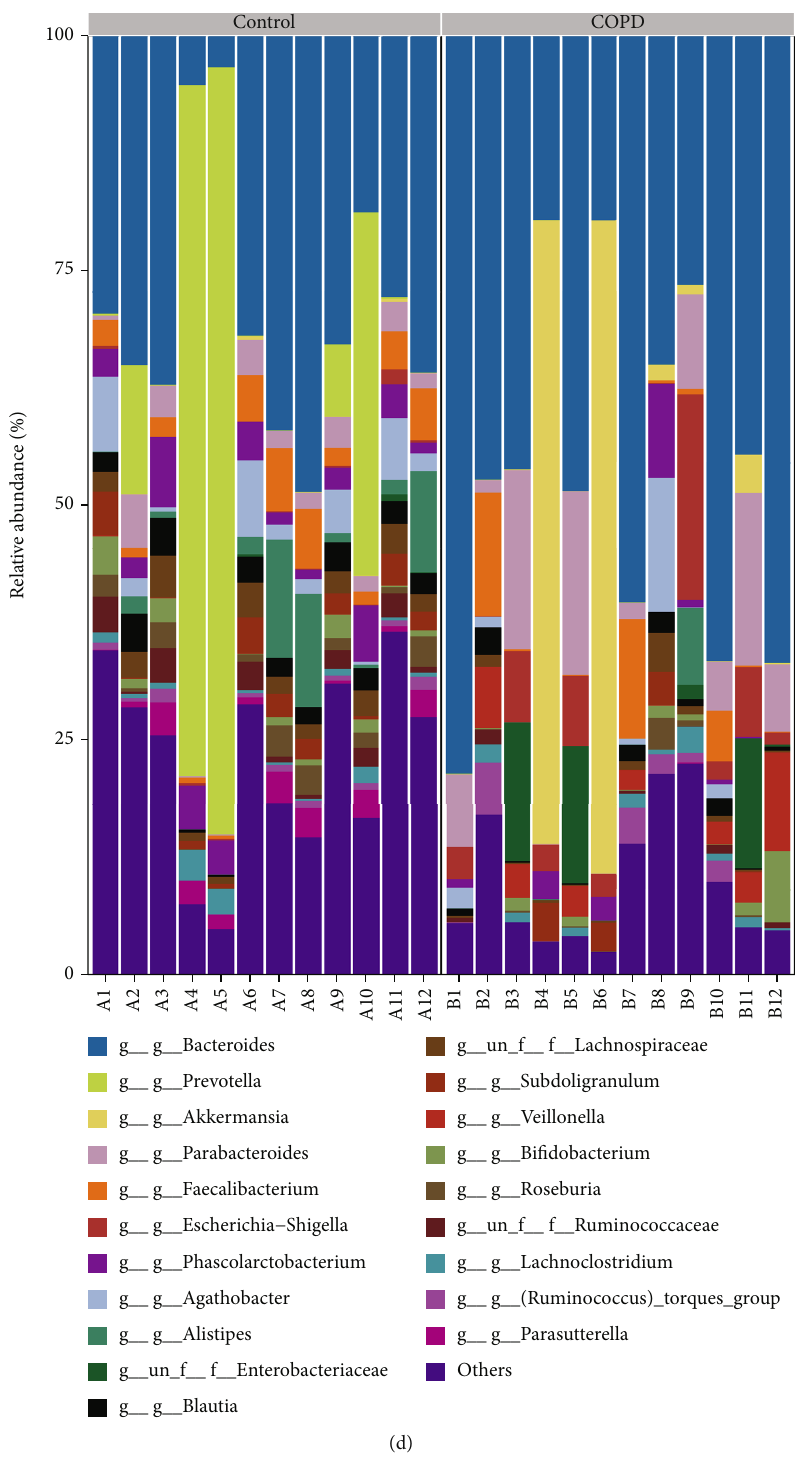
Figure 2: Analysis of the quantity and abundance of intestinal microbiota in COPD patients and control patients. (a) Rank abundance curve. (b) Venn diagram. (c, d) Relative abundance of species at phylum and genus